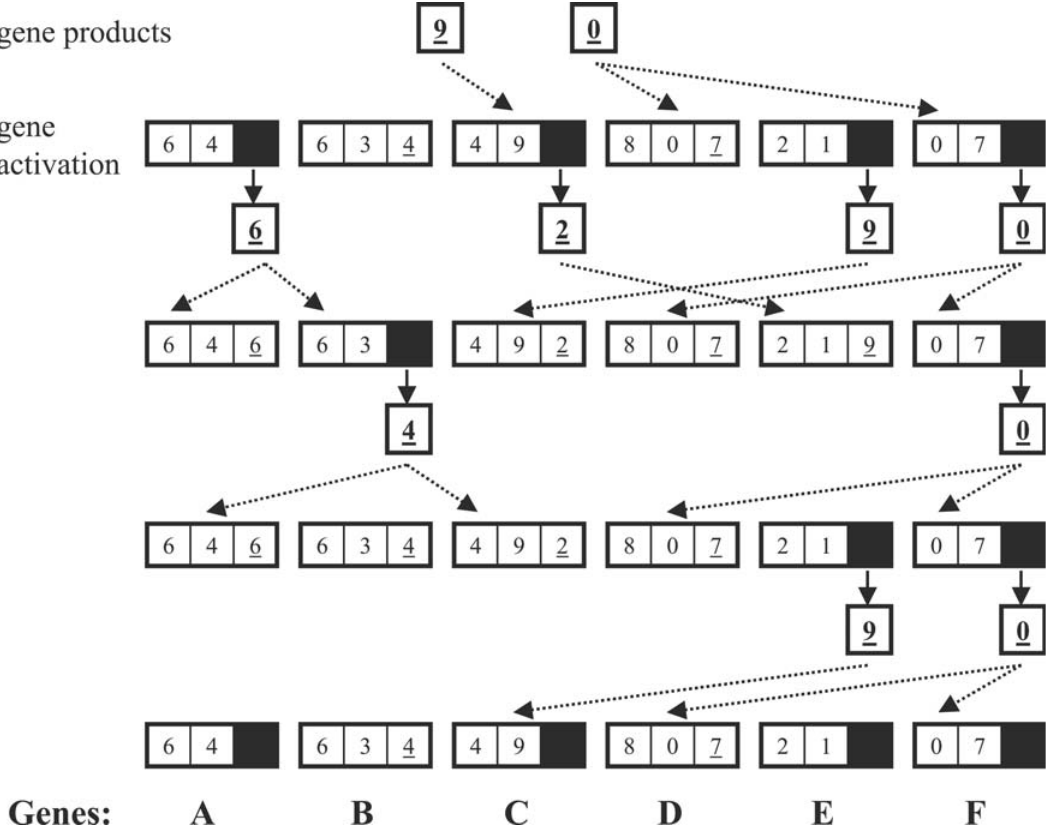
Figure 2. Diagram of four time steps in a 6-gene network. In the initial conditions, products 9 and 0 are present. Filled boxes represent expressed genes, dotted arrows represent binding of products to regulatory regions, and solid arrows represent production of gene products. From these initial conditions, this network enters a stable period-3 cyclic attractor. Boolean tables are not shown.